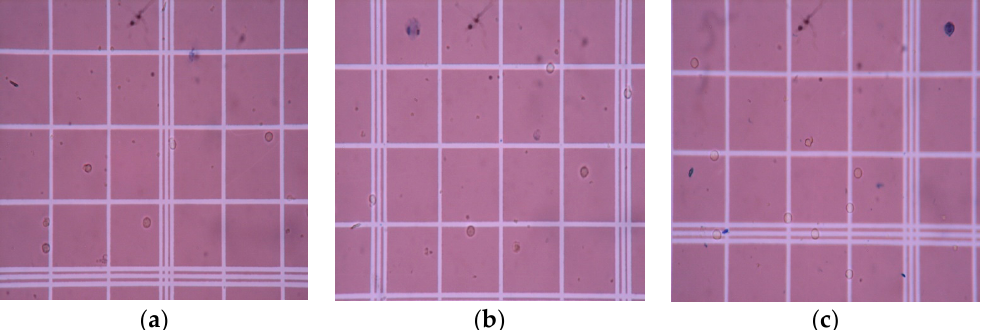
Figure 7. Cytocompatibility assay of ( a ) positive and ( b ) negative controls, supplemented RPMI and 0.1% Triton X ‐ 100, respectively.